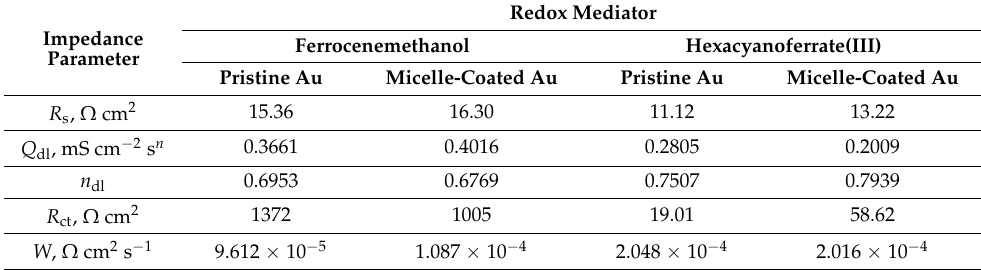
Table 1. Electrochemical parameters obtained from EIS data measured for pristine and micelle- modified gold for the heterogeneous electron transfer (HET) of ferrocenemethanol and hexacyanofer- rate(III). The meaning of the electrochemical parameters is given by the equivalent circuit shown in Figure 5.